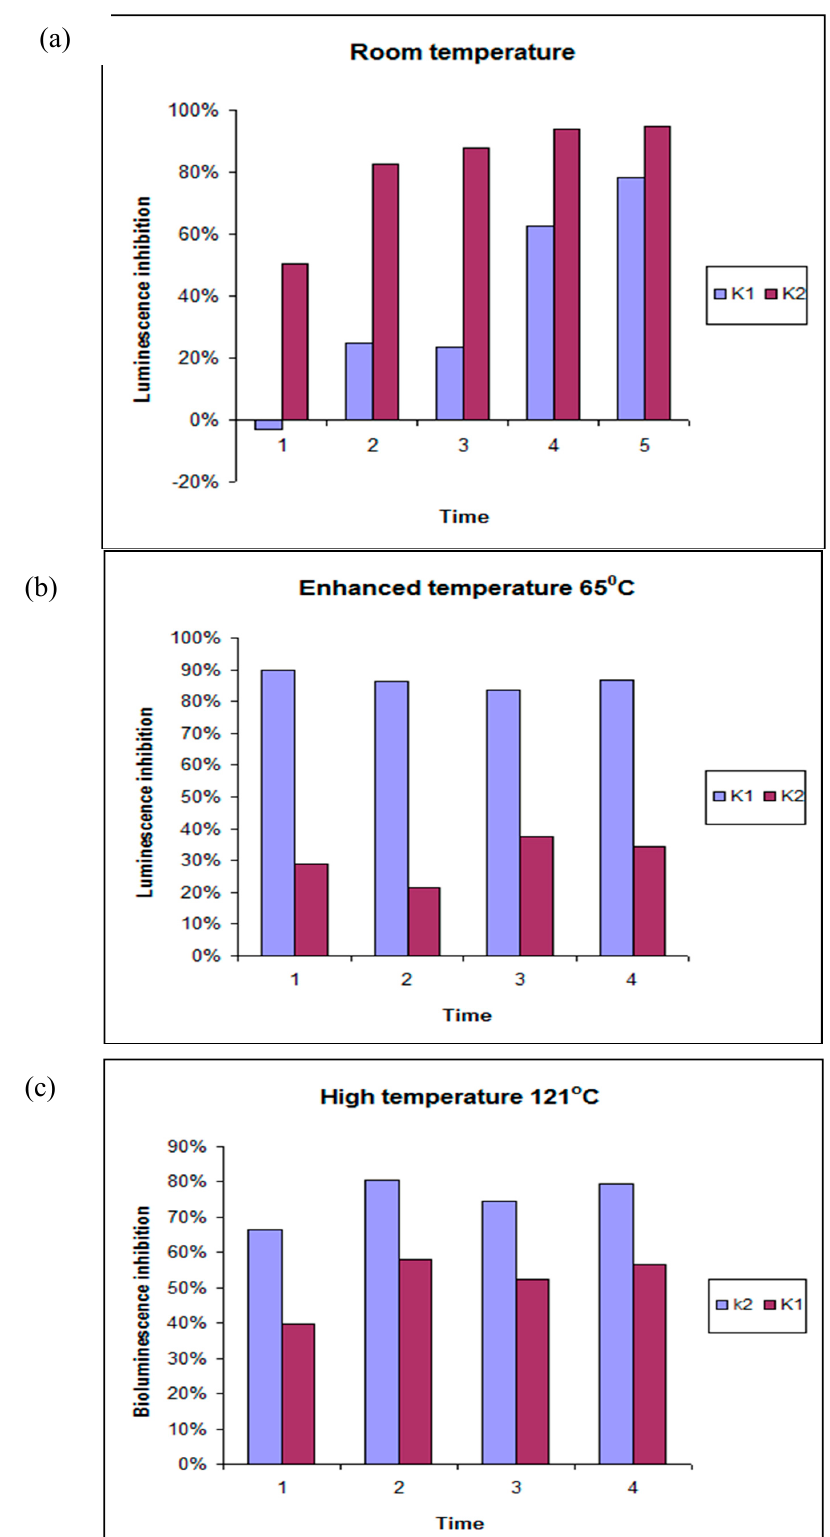
Figure 3. Luminescence inhibition (average values for clusters K1 and K2) as function of time at ( a ) room temperature, ( b ) enhanced temperature of 65 °C, ( c ) enhanced temperature of 121 °C (relative standard deviation of the means 3%).